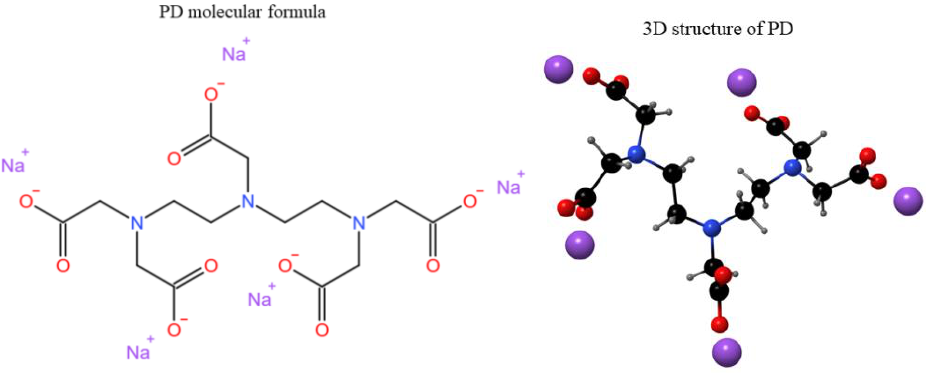
Figure 1. Pentasodium diethylenetriaminepentaacetate (PD) ’s structure.